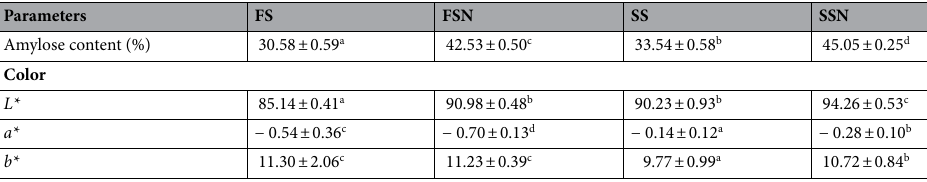
Table 2. Amylose content and color values of native and nano starch samples. Values expressed are mean ± standard deviation. Means in the row with different superscript (a, b, c & d) are significantly different at P ≥ 0.05. FS, FSN, SS and SSN represent native foxtail millet starch, nano foxtail millet starch, native sorghum starch and nano sorghum starch, respectively. ‘ L* ’ = lightness, ‘ a* ’ = redness to greenness and ‘ b* ’ = yellowness to